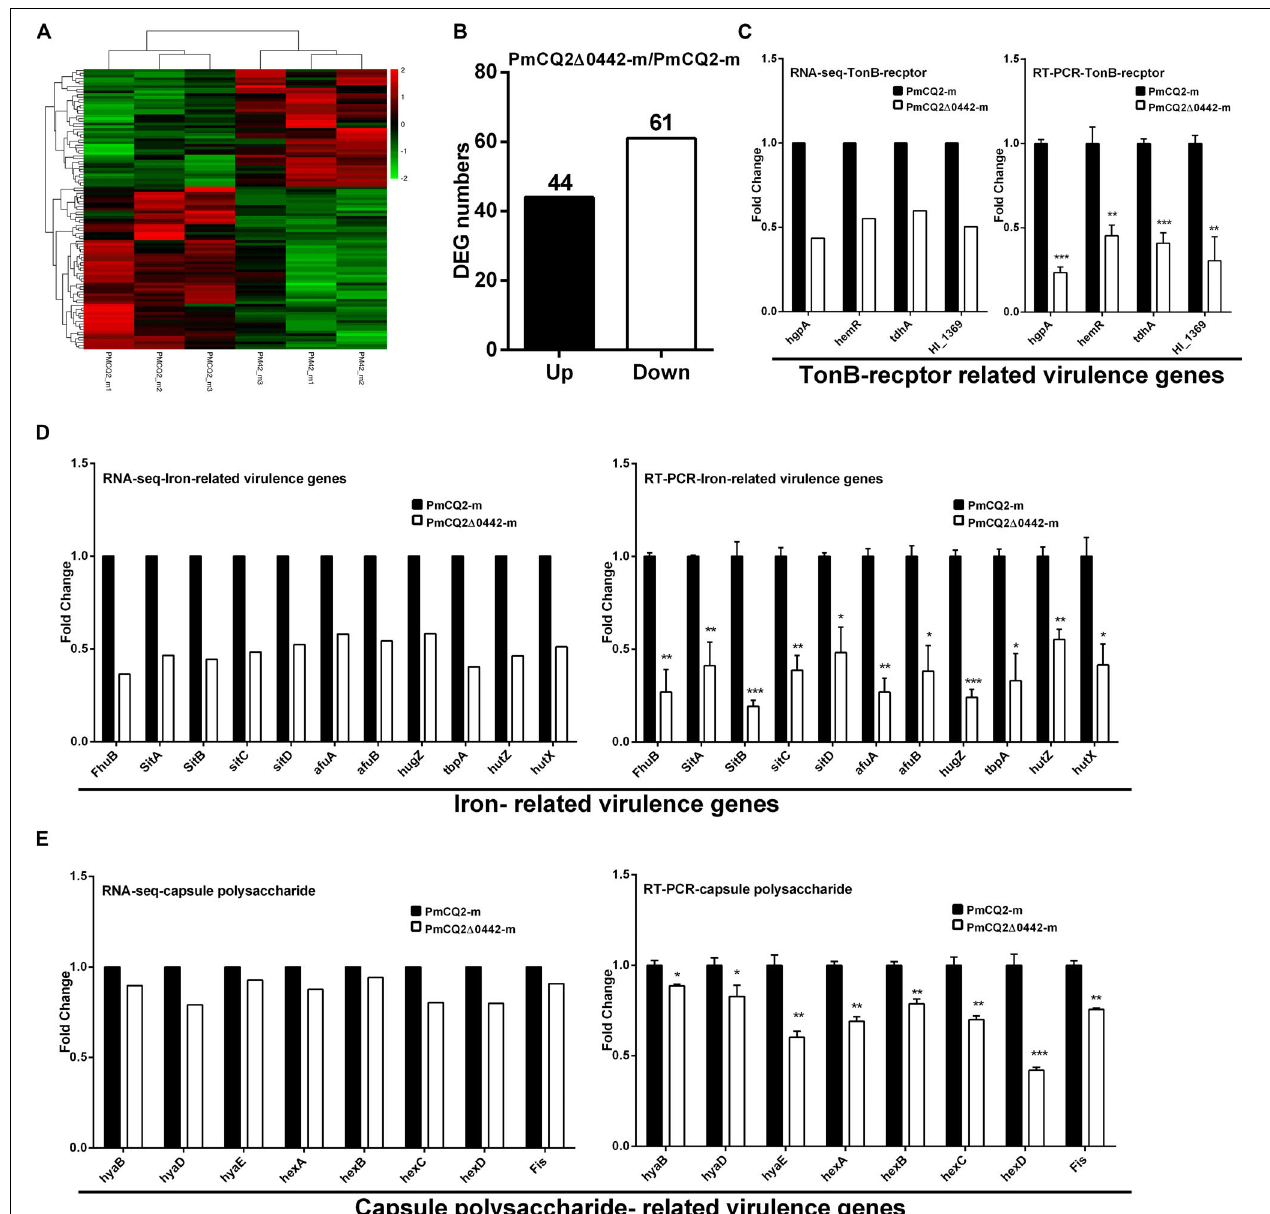
FIGURE 5 | Virulence gene transcription in vivo . (A) Heat map for clustering of DEGs (FC ≥ 1.5) of PmCQ2 and PmCQ2- (cid:49) 0442 in vivo . (B) The up/down-regulated DEGs (FC ≥ 1.5) of PmCQ2 and PmCQ2- (cid:49) 0442 in vivo . (C) TonB receptor-related DEGs (FC ≥ 1.5) in RNA-seq and in RT-PCR ( n = 3). (D) Iron-related DEGs (FC ≥ 1.5) in RNA-seq and in RT-PCR ( n = 3). (E) Capsule synthesis and transport- related DEGs (FC ≥ 1.5) in RNA-seq and in RT-PCR ( n = 3). Panels (C–E) were representative of two independent experiments with 3 replicates per group and analyzed by multiple comparative analysis, and expressed as means ± SD (* p < 0.05, ** p < 0.01, *** p <